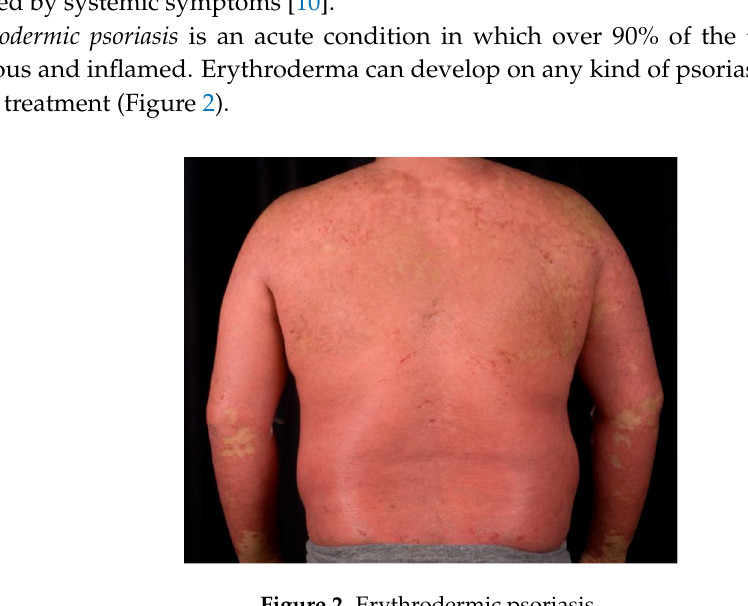
Figure 2. Erythrodermic psoriasis.